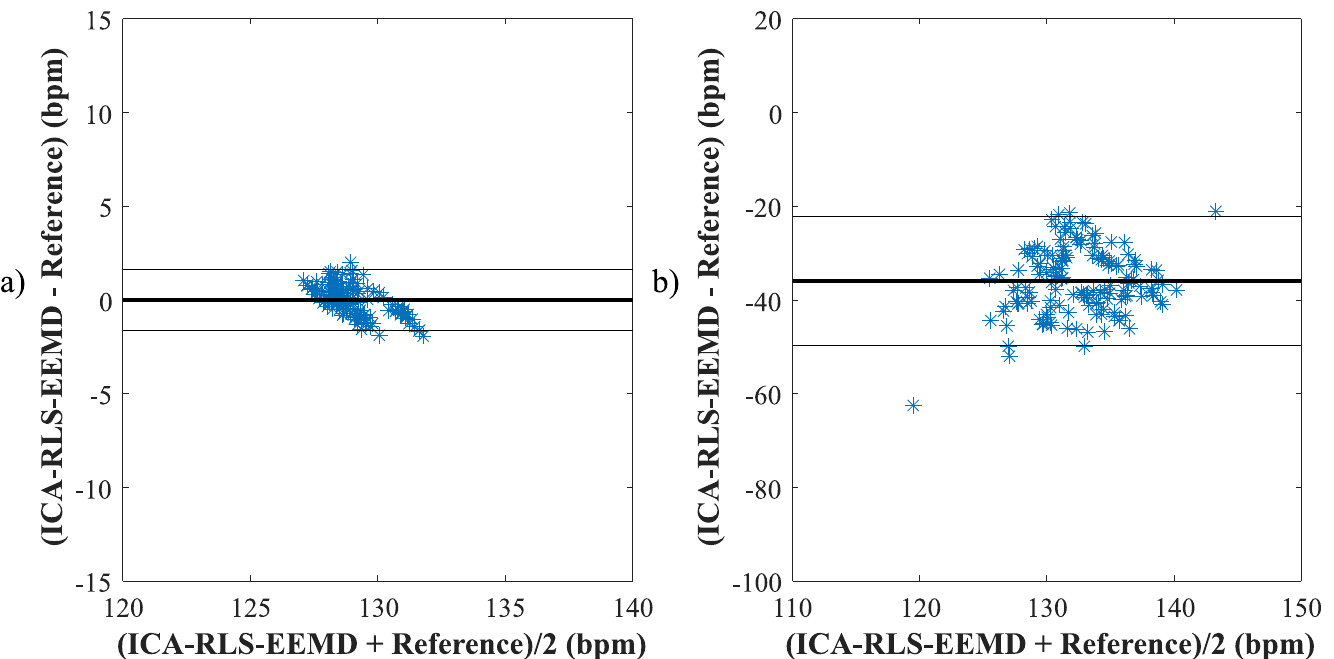
Fig 9. Comparison of reference and estimated values using the ICA-RLS-EEMD method when determining the fHR a) for recording a05 and b) for recording a18 based on the Bland-Altman plots.